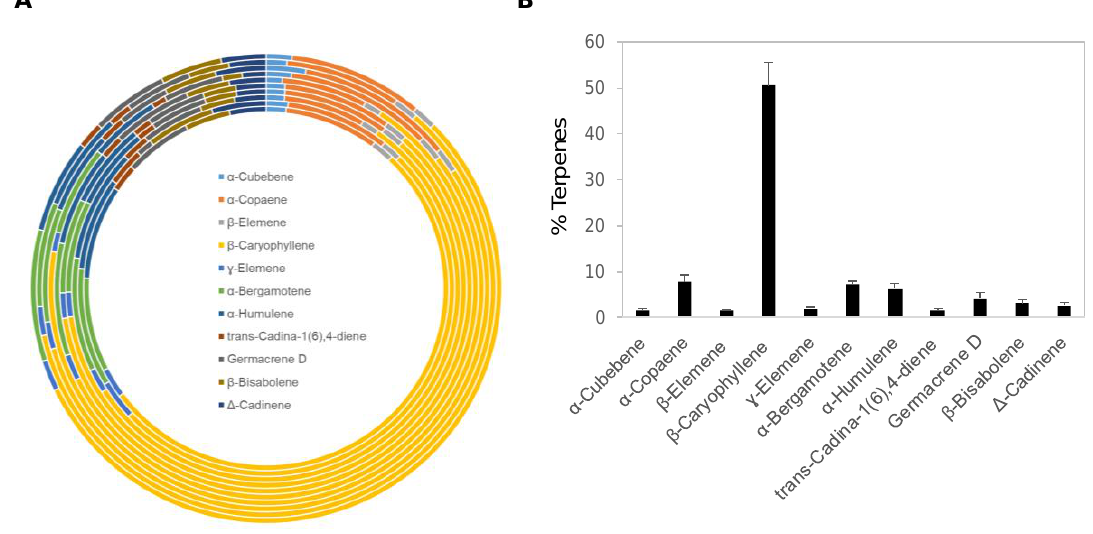
Figure 1. Terpene composition of copaiba essential oil. ( A ) Distribution of 11 major terpenes in 10 different batches of copaiba essential oil. Terpene composition was analyzed with gas chromatography coupled with mass spectrometry. ( B ) Percentages of 11 major terpenes in copaiba essential oil. The error bars represent the standard deviations across 10 different batches of copaiba essential oil. Table 1. Terpene composition of copaiba essential oil .